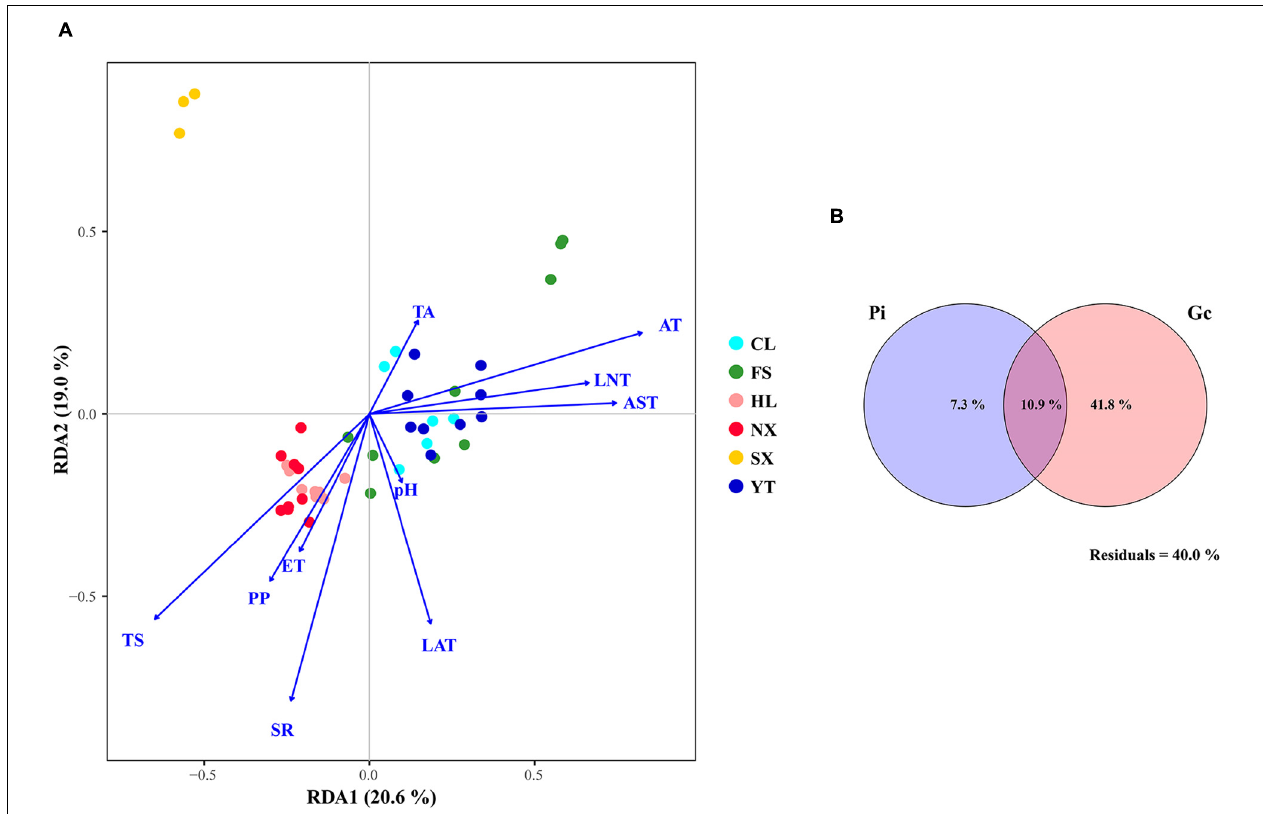
FIGURE 5 | (A) RDA and (B) VPA of the environmental factors related to the Marselan must fungal communities. For the VPA, the variables presented in the RDA were separated into two groups: Gc (SR, AT, AST, LAT, LNT, and ET), and Pi (TS, PP, TA, and